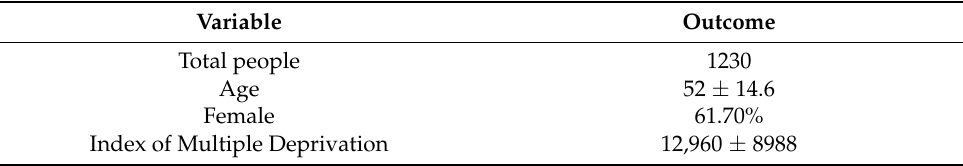
Table 1. Demographics of the program